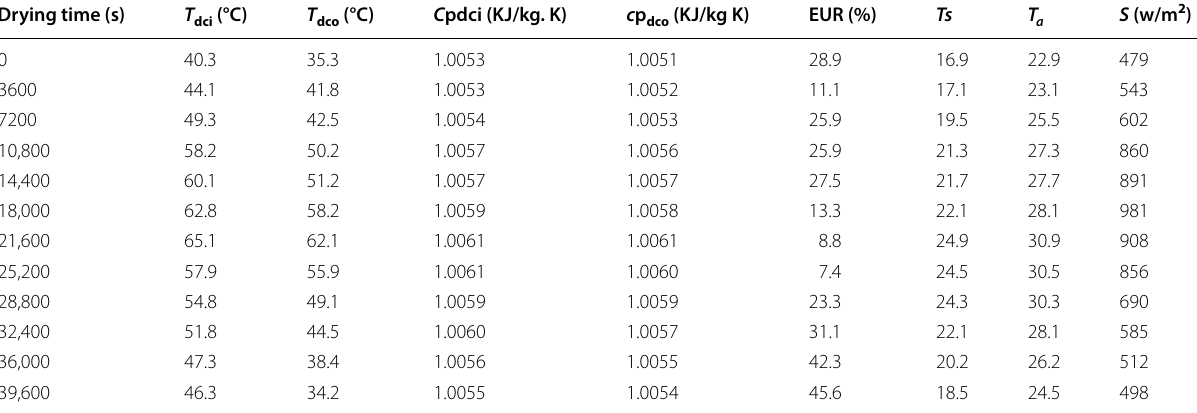
Table 17 Result energy analysis potato 2nd